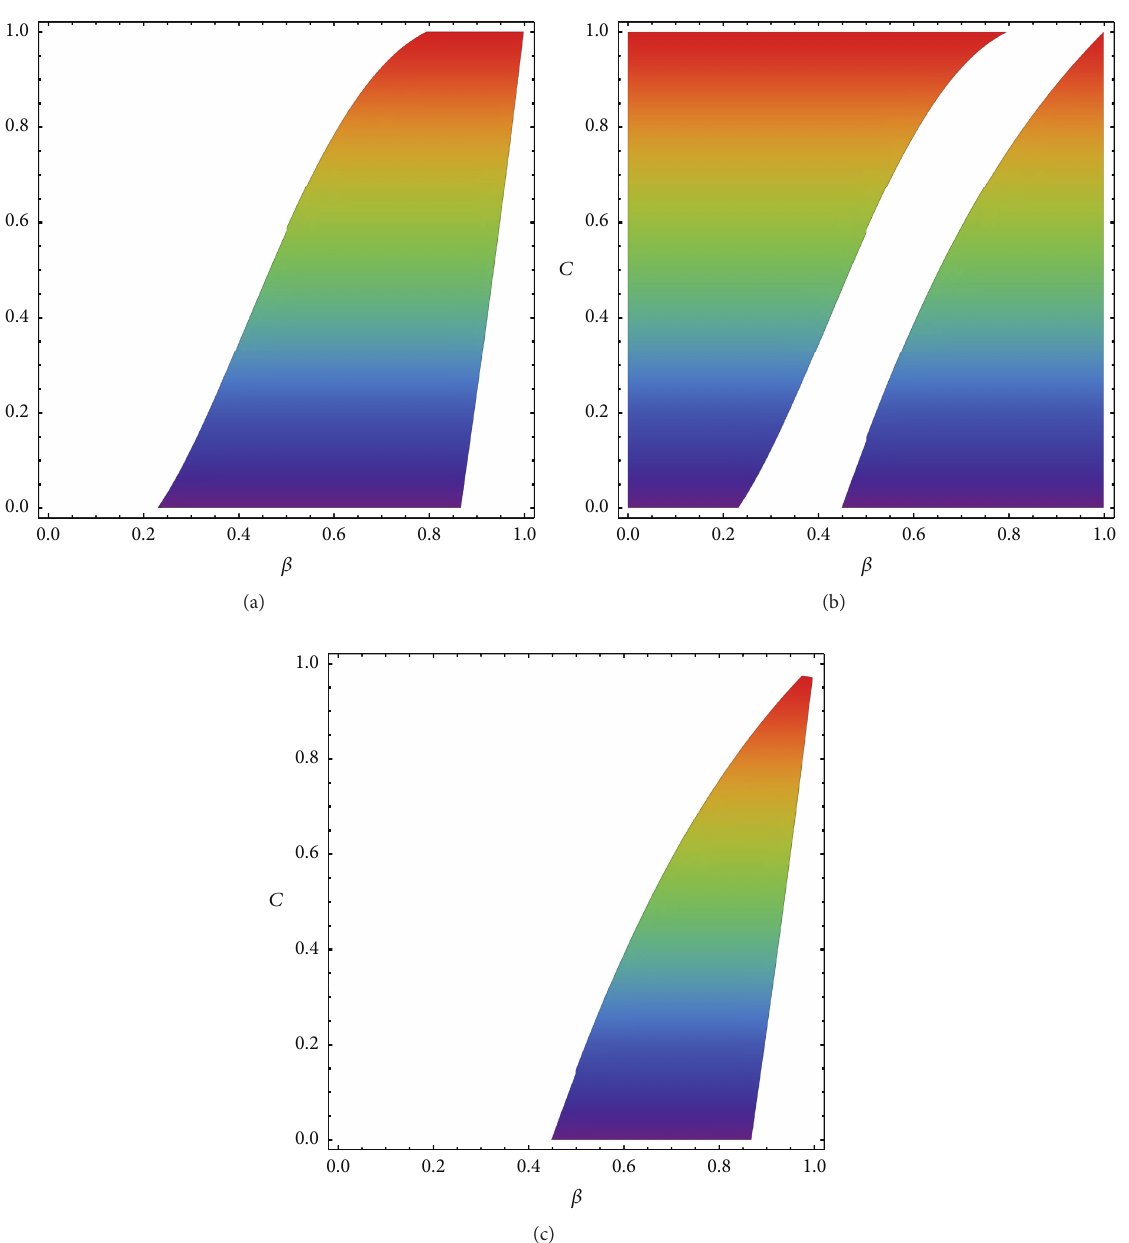
Figure 8: Central configurations region in the trapezoidal 5-BP when 𝛼 = 𝛽 (a) 𝑚 0 > 0 , (b) 𝑀 > 0 , and (c) 𝑚 0 > 0 and 𝑀 > 0 .